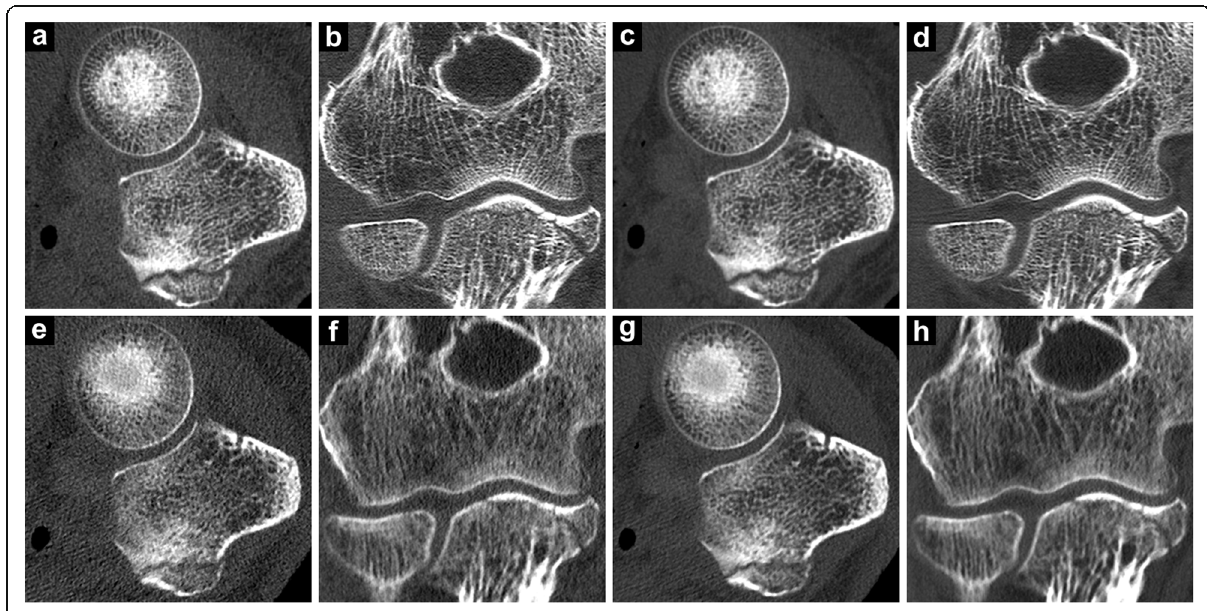
Fig. 3 Representative cone-beam computed tomography (CBCT) and multidetector computed tomography (MDCT) images in the axial and